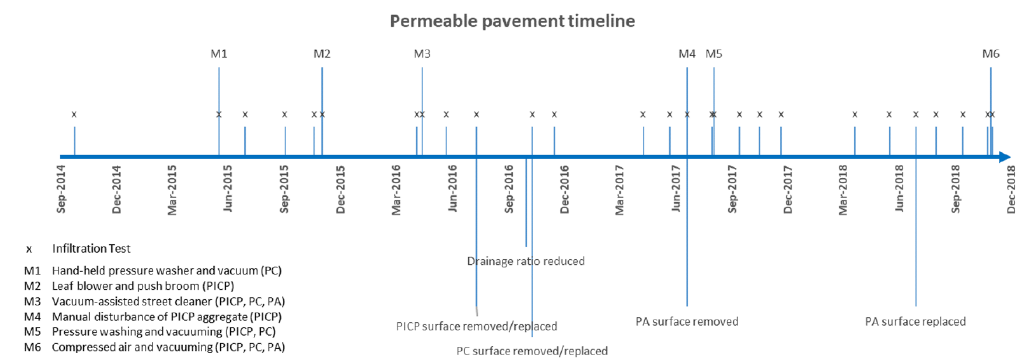
Figure 2. Timeline showing the occurrence of restorative maintenance activities, infiltration tests, and site activity for permeable interlocking pavers (PICP), pervious concrete (PC), and porous asphalt (PA) test plots.